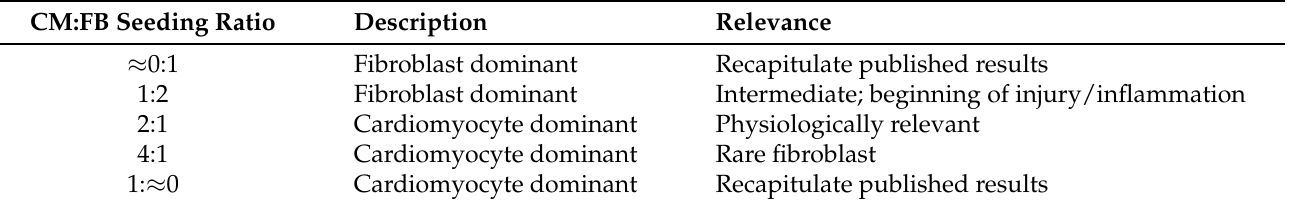
Figure 1. Co-culture of cardiomyocytes and fibroblasts labeled with ( A ) α -actinin, ( B ) actin, and ( C ) α -actinin (red), actin (green), and DAPI (blue). ( D ) Cells classified as mature cardiomyocytes are shaded red in the α -actinin labeled image shown in A. ( E ) The orientation of actin at each pixel is plotted as a purple arrow on top of the actin labeled image shown in B. ( F ) The orientation of actin at each pixel as shown in B but colored red for cardiomyocytes and green for fibroblasts. Scale bars: 20 µm. Table 2. Co-culture cell type